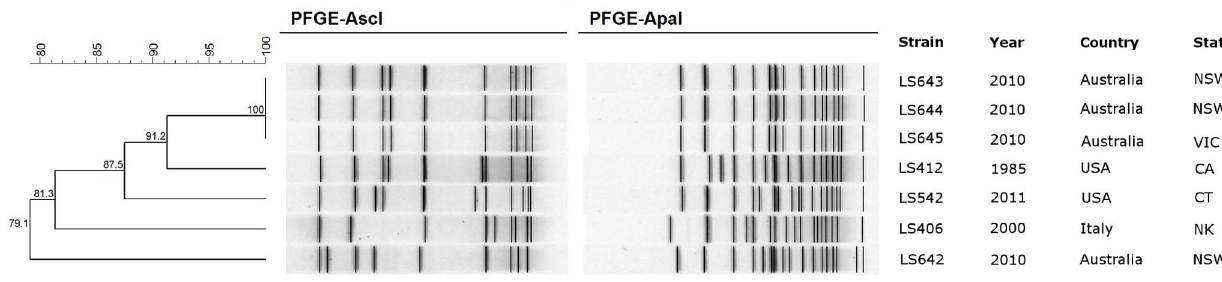
Figure 2. ApaI/AscI PFGE profiles of L.monocytogenes strains 4b and IVb-v1. The dendrogram was calculated and drawn using Bionumerics software. NSW; New South Wales, VIC; Victoria, CA; California, CT; Connecticut, and NK;Not